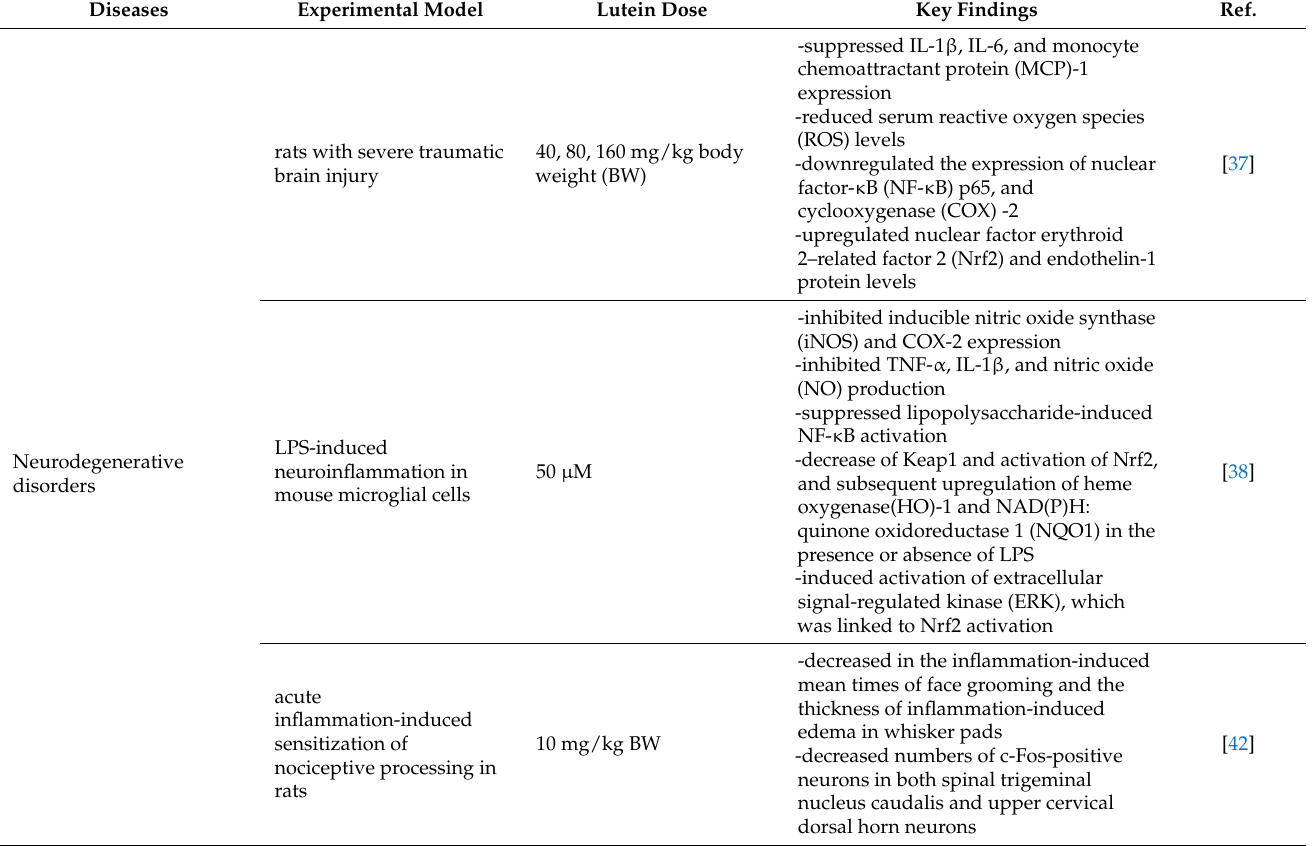
Table 1. The effects of lutein on inflammatory responses in experimental models. Diseases Experimental Model Key Findings